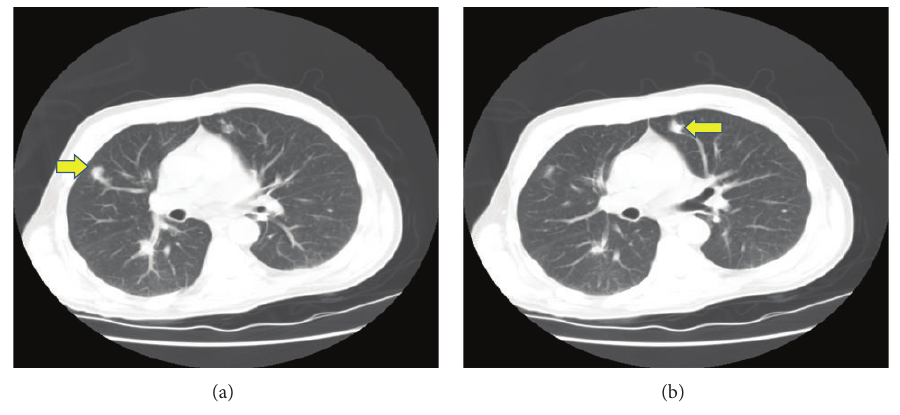
Figure 2: CT chest showing the pulmonary nodules.